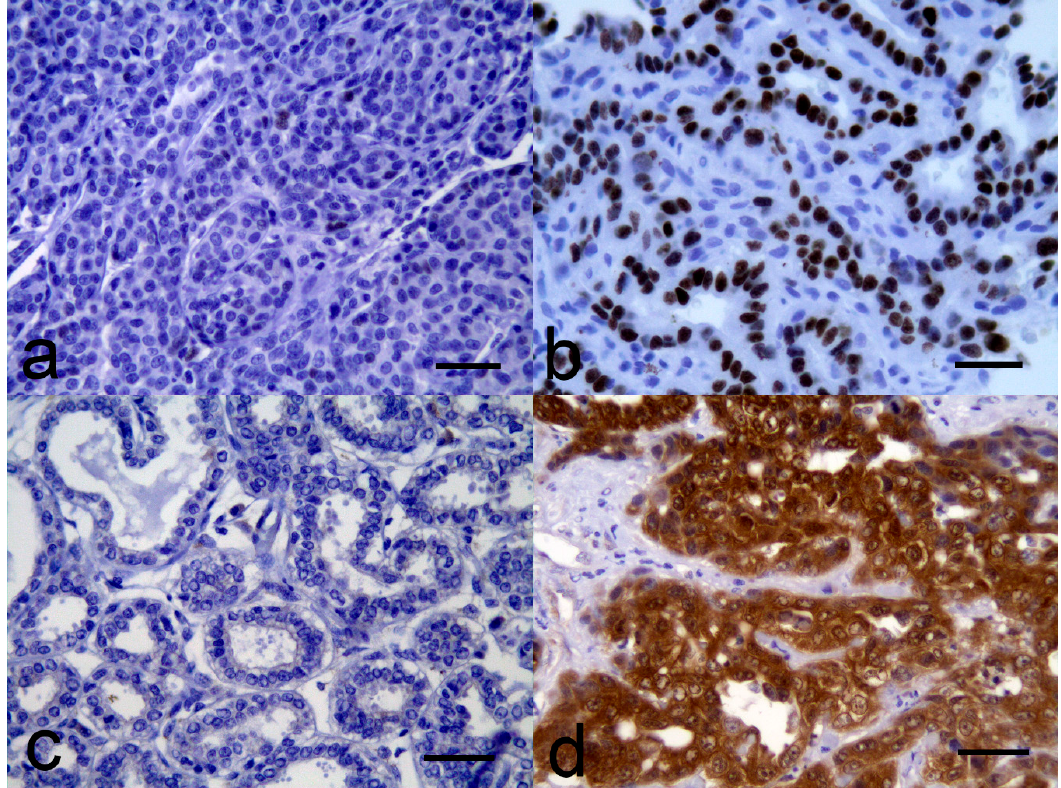
Figure 1. Canine malignant mammary gland neoplasms: ( a ) No significant immunostaining for p53 is visible within the neoplastic cells; ( b ) Intense nuclear p53 immunostaining is visible within most neoplastic cells; ( c ) While a proportion of stromal cells contain weak intracytoplasmic p16CDK2A immunostaining, immunostaining is absent from the neoplastic cells. ( d ) Intense intranuclear and intracytoplasmic p16 CDK2A immunostaining is visible within almost all of the neoplastic cells. All bars = 50 µm.